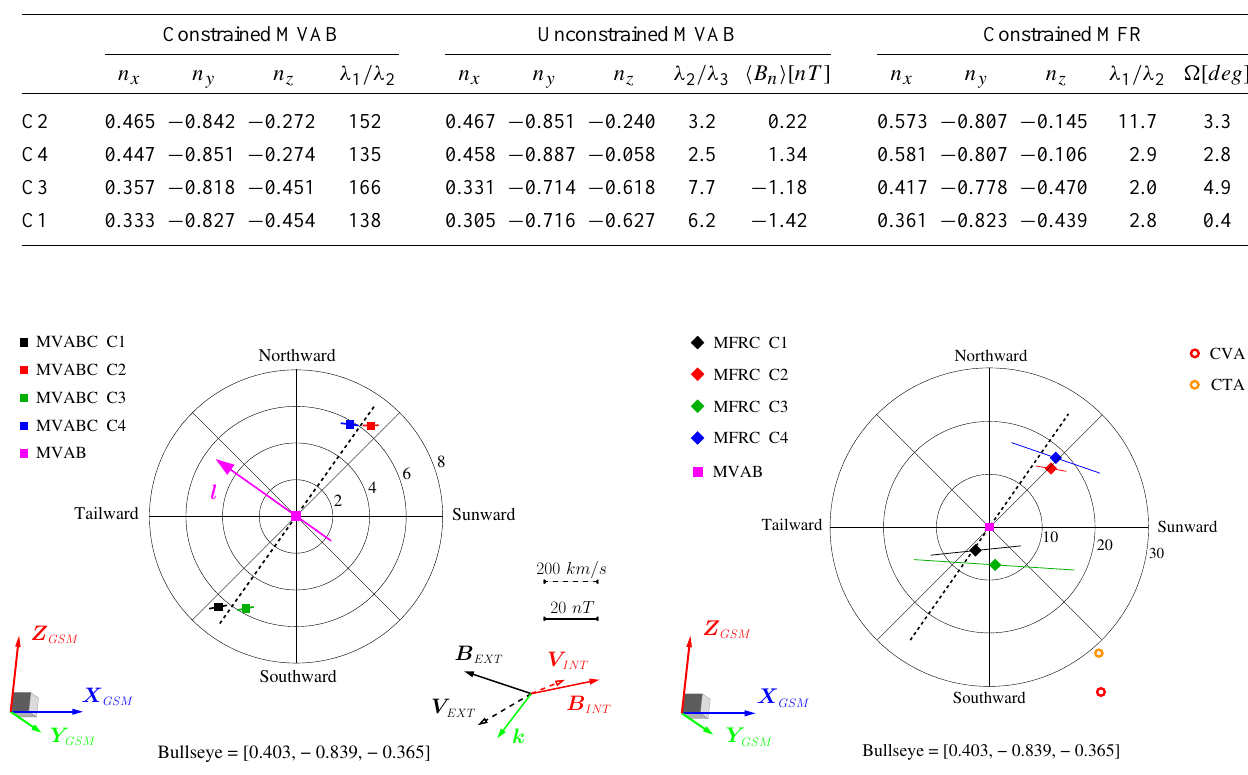
Fig. 3. Polar plot showing the orientation of the four individual normals provided by the constrained MVAB technique (the squares in the mission color code) with respect to their average orientation, taken as reference direction (the central square in magenta). The circles designate directions of equal inclination, in degrees. The individual normals are located roughly in one plane (dashed line), indicating a two-dimensional MP with the invariant direction oriented perpendicular (the unit vector l in magenta). In the lower left corner, the orientation of GSM coordinate system is shown, as seen when looking against the reference, h n i MVAB direction. The lower right corner presents the tangential components of the magnetic field and velocity flow, as measured by C1, in the regions adjacent to the MP interval: in the magnetosphere (red) and in the magnetosheath (black). The scales of the vectors are also shown. The unit vector k (green) is in the tangent plane and perpendicular to l . More details are provided in the text.